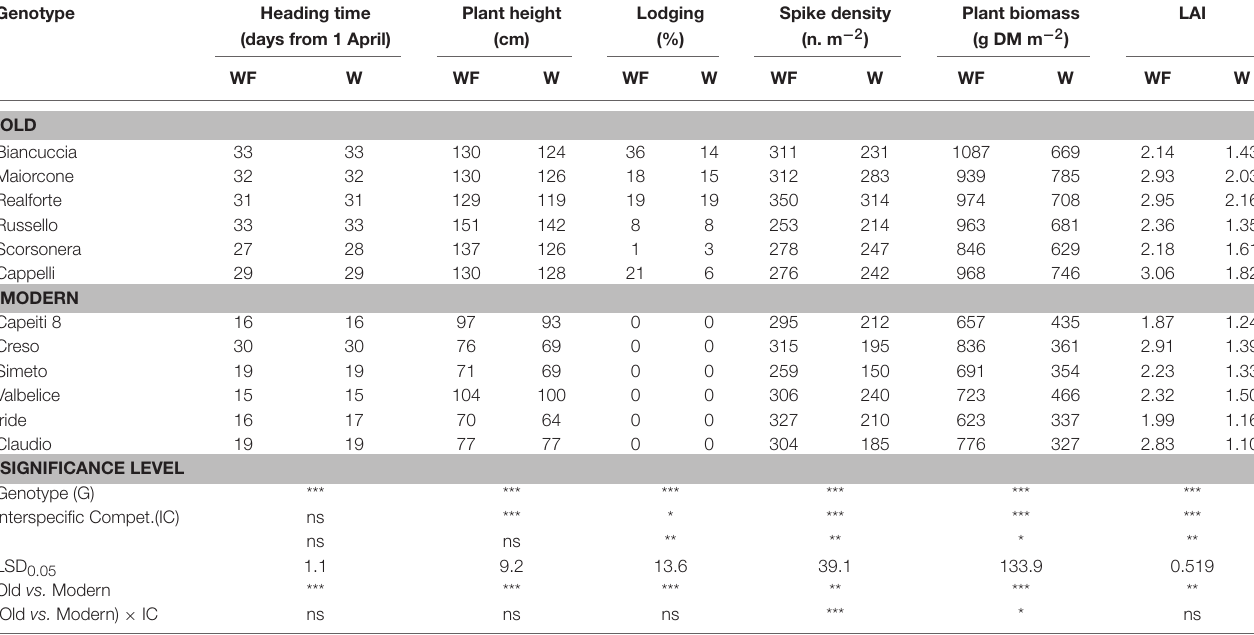
TABLE 3 | Wheat traits measured at heading in 12 genotypes grown in weed-free (WF) and weedy (W) conditions. Genotype Heading time